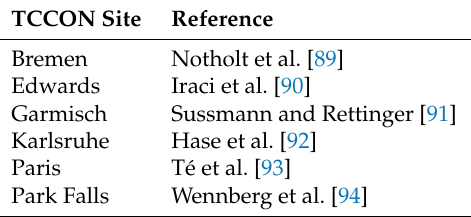
Table A1. Total Carbon Column Observing Network (TCCON) sites with the references to the data used in this publication.